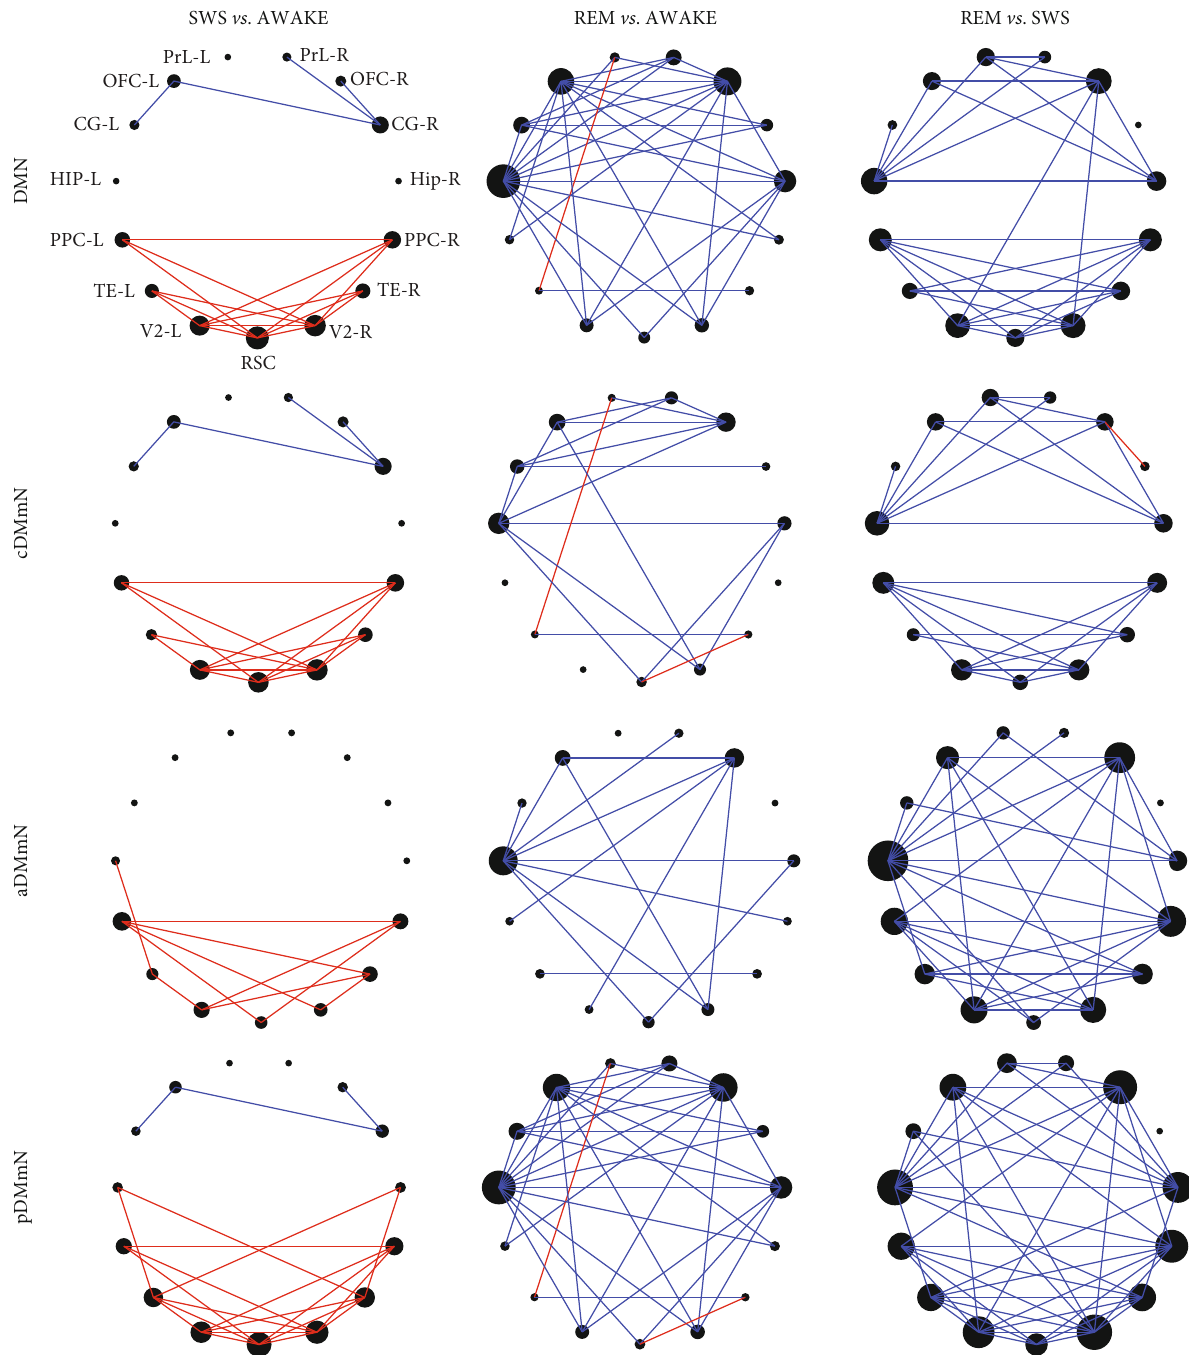
Figure 7: Comparisons of the three CAMP networks and the DMN among three states of consciousness. The red lines indicate signi fi cantly increased FC with p < 0 : 0002 (FWE correction). The blue lines indicate signi fi cantly decreased FC with p < 0 : 0002 (FWE